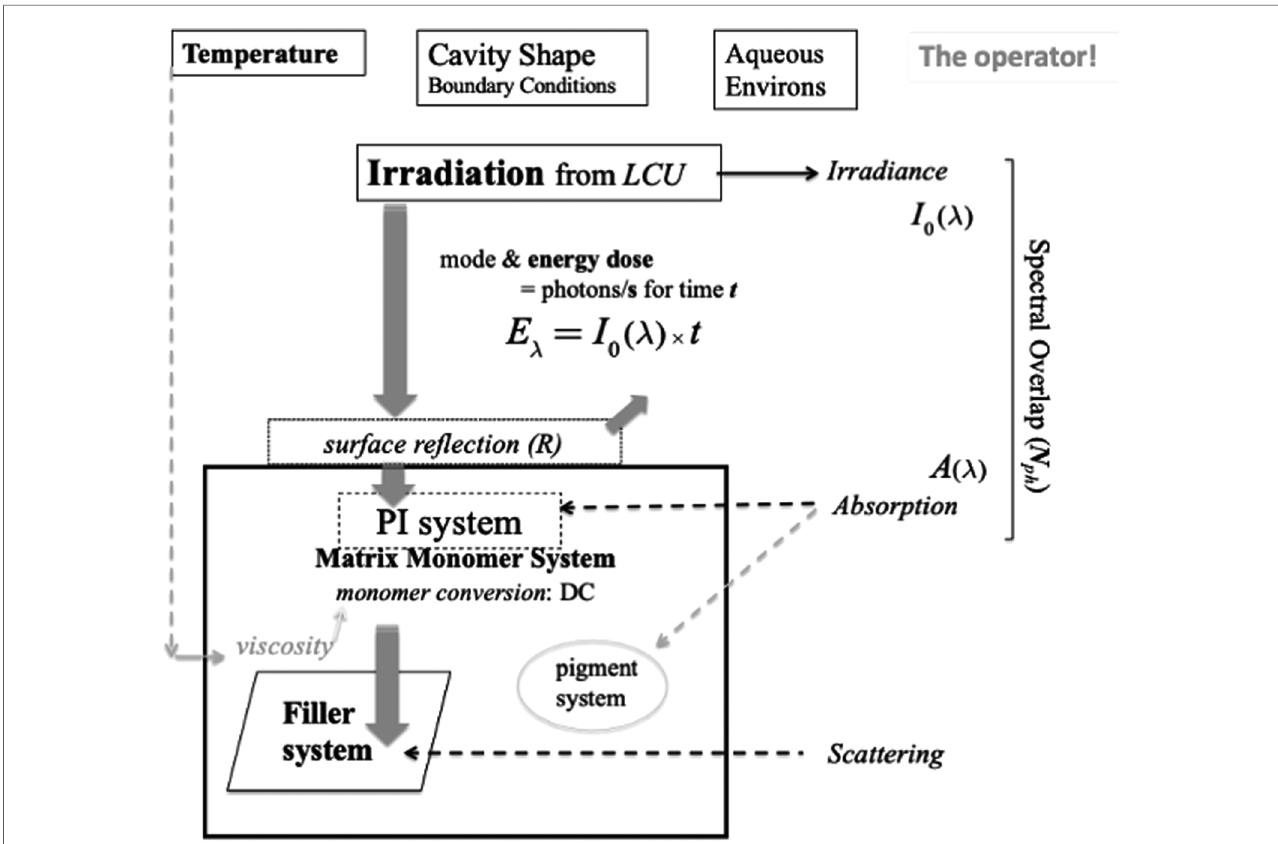
FIGURE 5 Schematic of irradiation and photo-initiation of a resin-composite system. The penetration and interaction of visible photons with the composite formulation is represented, in the context of the extrinsic factors of the dental-clinical environment and boundary conditions. The clinical operator also plays a crucial role in managing the process. Light scattering arises principally at the interfaces of reinforcing particles. However, any resin-phase porosity — if present — can also induce